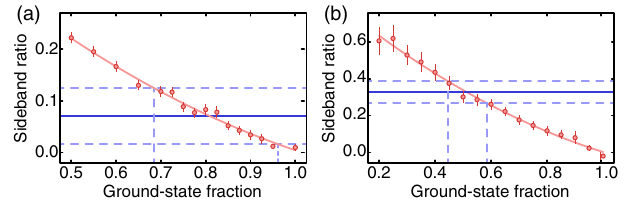
FIG. 9. Sideband thermometry. (a),(b) Ratio of red to blue sideband amplitude as a function of ground-state fraction, obtained via fitting simulated spectra for the (a) radial and (b) axial spectra. The dependence on ground-state fraction is fitted to a quadratic function (red curve). The solid blue line is the fitted sideband ratio for our experimental data, with dashed lines representing a 1 σ confidence interval. We quote a range of consistent ground-state fractions where this confidence interval intersects the fitted quadratic